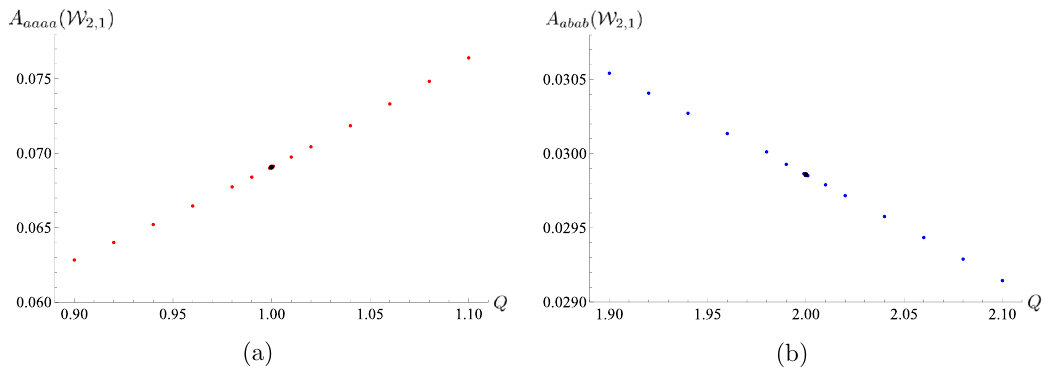
Figure 17 . The amplitudes A aaaa ( W 2 , 1 ) at Q = 1 (left) and A abab ( W 2 , 1 ) at Q = 2 (right). The red and blue dots are the bootstrap results and the slightly bigger black dots are the exact expressions (4.85) and (4.93) obtained from the requirement of singularity